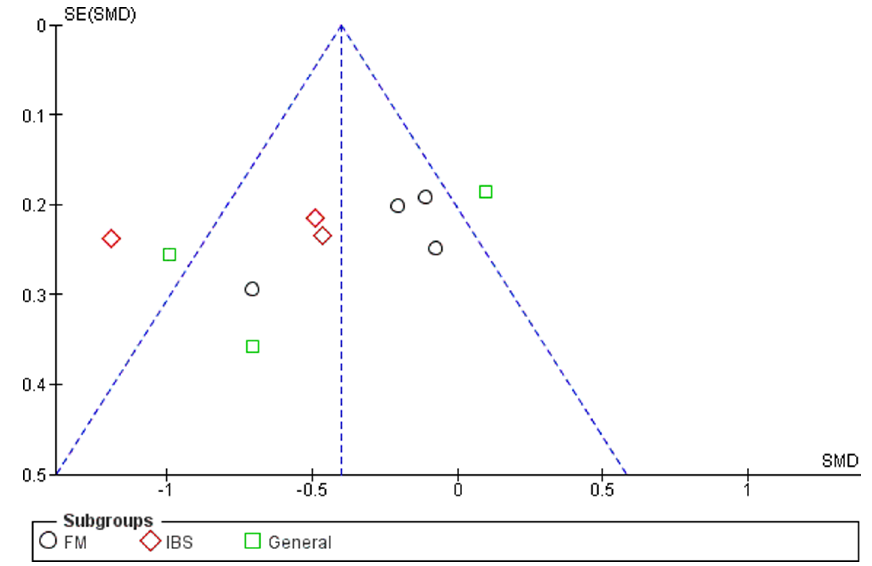
Figure 2. Funnel plot for pain. doi:10.1371/journal.pone.0071834.g002 PLOS ONE |